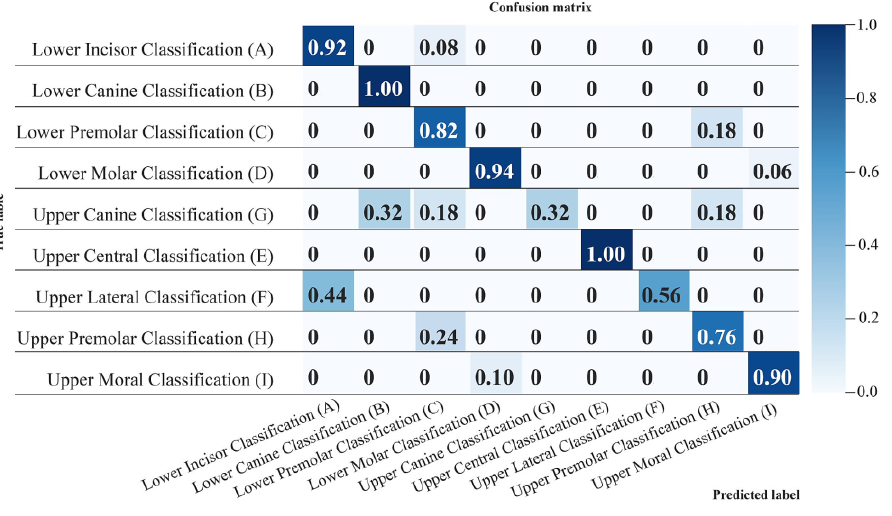
Figure 5. Confusion Matrix of the convolutional neural network (CNN)-based AI model for all teeth classes (Class A to H). The correct classification is presented in the diagonal grids, with classes B and E showing the highest accuracy of 1 (100%) and Class G showing the lowest accuracy of 0.32